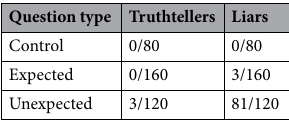
Table 3. Error rate to control, expected and unexpected question for liars and truthtellers.